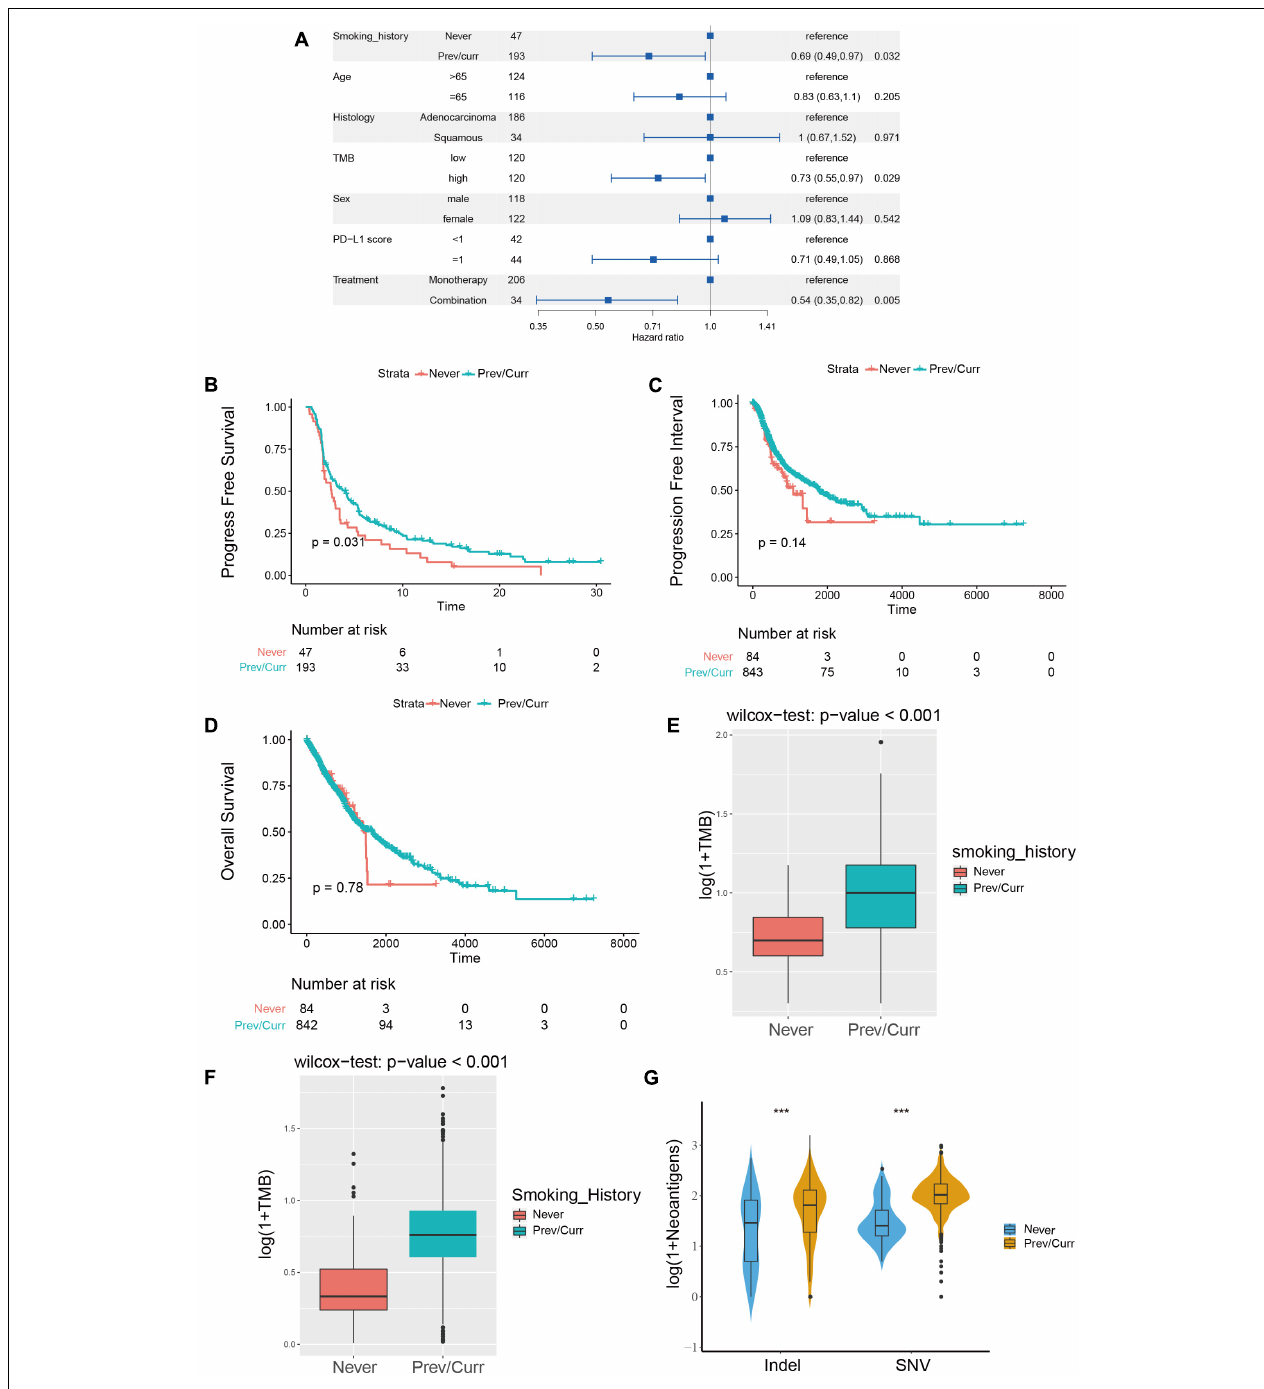
FIGURE 2 | Association between the smoking status and clinical outcomes and immunogenicity in NSCLC. (A) Forest plots for the results of the univariate Cox regression analyses. The p -value of smoking status is less than 0.05, the main portion of the forest plot presents the hazard ratio (HR) and 95% CI, and the HR indicates the predictors of favorable (HR < 1) or poor (HR > 1) PFS. (B) Kaplan–Meier analysis was used to compare progression-free survival (PFS) of previous or current smokers with that of non-smokers in the ICI treatment in NSCLC cohort from MSKCC. (C,D) Kaplan–Meier analysis was used to compare progression-free interval (PFI) (C) and overall survival (OS) (D) of previous or current smokers with that of non-smokers in the TCGA Pan-Lung Cancer cohort (without ICI treatment). (E) Comparison of tumor mutational burden (TMB) between the previous or current smokers and non-smokers in the ICI treatment cohort from MSKCC. (F) Comparison of tumor mutational burden (TMB) between the previous or current smokers and non-smokers in the TCGA Pan-Lung Cancer. (G) Comparison of neoantigen load between the previous or current smokers and non-smokers in the TCGA Pan-Lung Cancer. (E–G) All expression values are logarithmized by log(1 + x) using Wilcoxon test for variance analysis. * p < 0.05; ** p < 0.01; *** p < 0.001; **** p < 0.0001; ns, not significant.